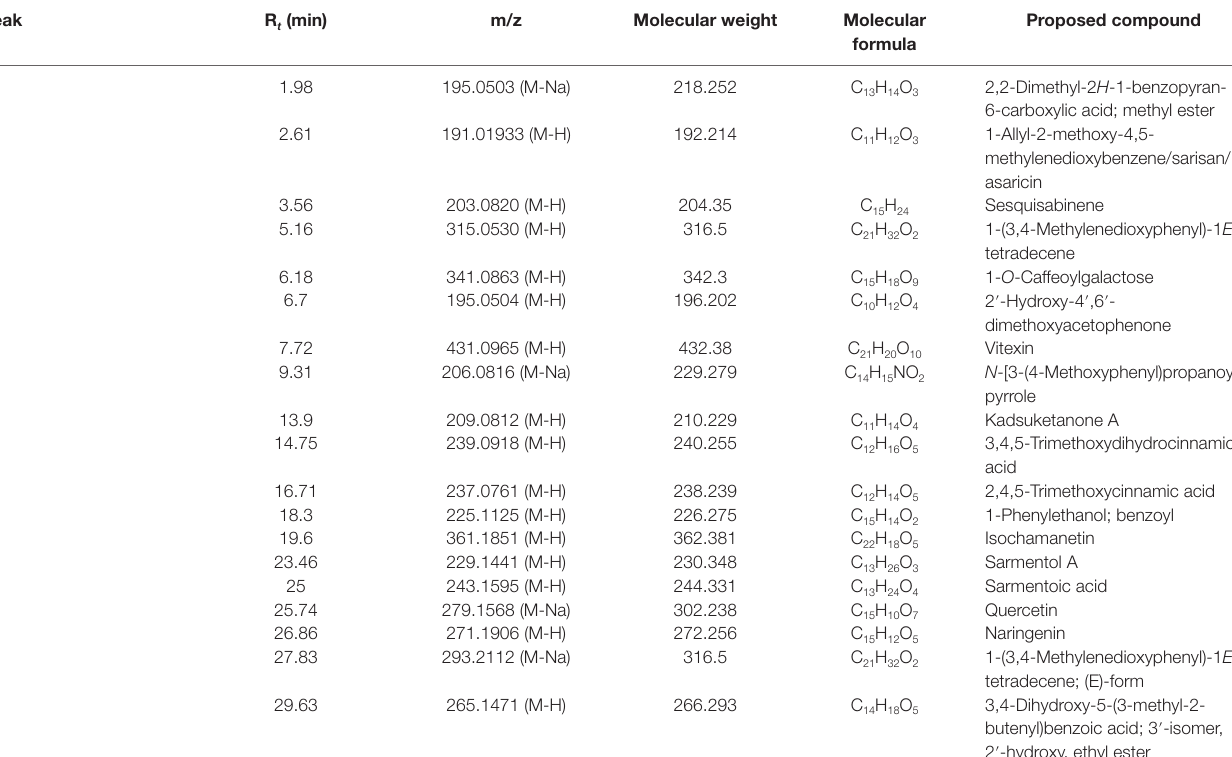
TABLE 1 | Retention time (R t ) and mass spectra details for compounds identified in the negative mode of liquid chromatography (LC)–mass spectrometry (MS) Orbitrap full-scan analysis. Peak R t (min)